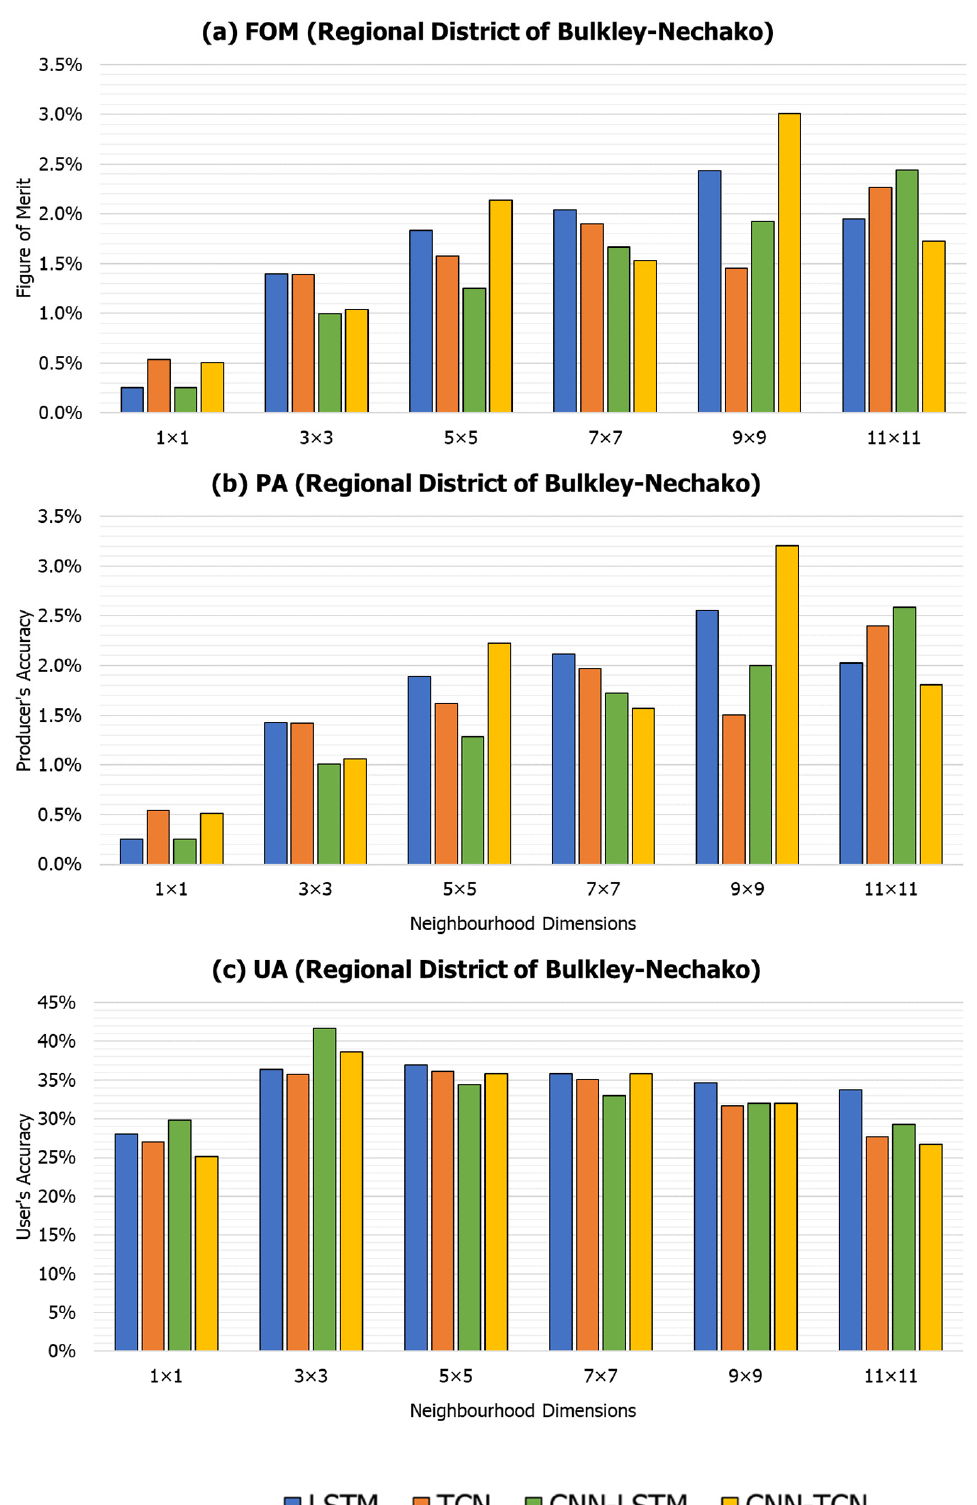
Figure 6. Measures of ( a ) Figure of Merit (FOM), ( b ) Producer’s Accuracy (PA), and ( c ) User’s Accuracy (UA) obtained for the full Regional District of Bulkley-Nechako.